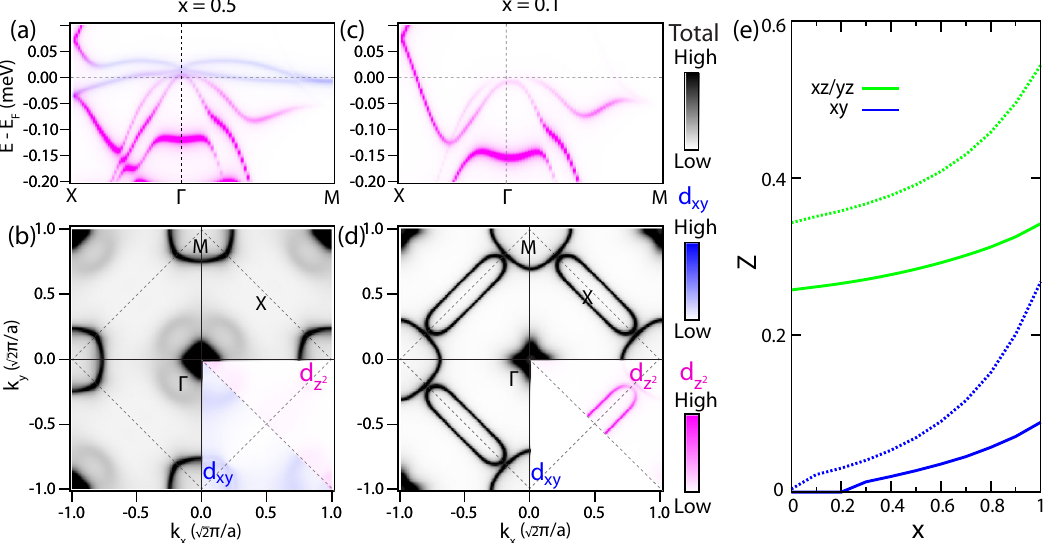
Fig. 4 Theoretical calculations of FeTe 1 − x Se x . a Calculated band structure projected onto different orbitals for the strongly correlated metallic phase in FeTe 0.5 Se 0.5 . The magenta intensity indicates d z 2 orbital character, whereas blue intensity the d xy orbital. b Calculated Fermi surface for FeTe 0.5 Se 0.5 , where the lower right quadrant shows the d z 2 and d xy intensity respectively. c , d Same as ( a , b ) but for the orbital-selective Mott phase FeTe 0.9 Se 0.1 . e Orbital- resolved coherence factor Z as a function of x . The solid line represents U = 3 eV and dashed line represents U = 2.65 eV. U denotes the intraorbital Coulomb